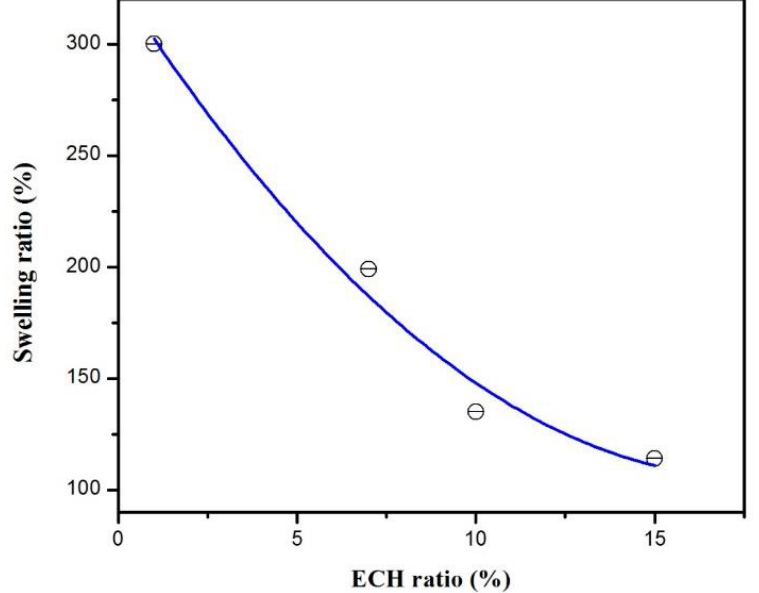
Figure 9. Swelling equilibrium of cellulose hydrogels with different ECH ratio in HEMA reagent solution.